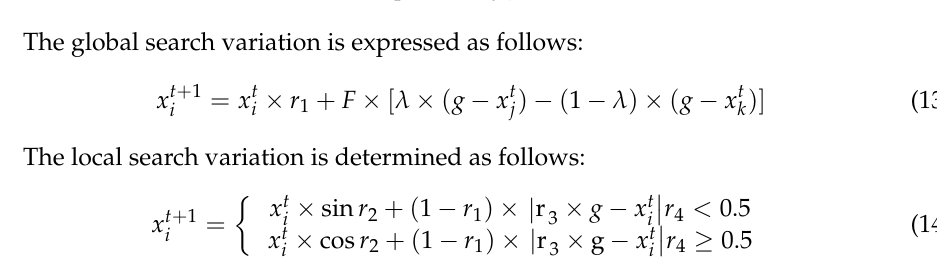
Figure 2. Iterative curve of transformation probability p.